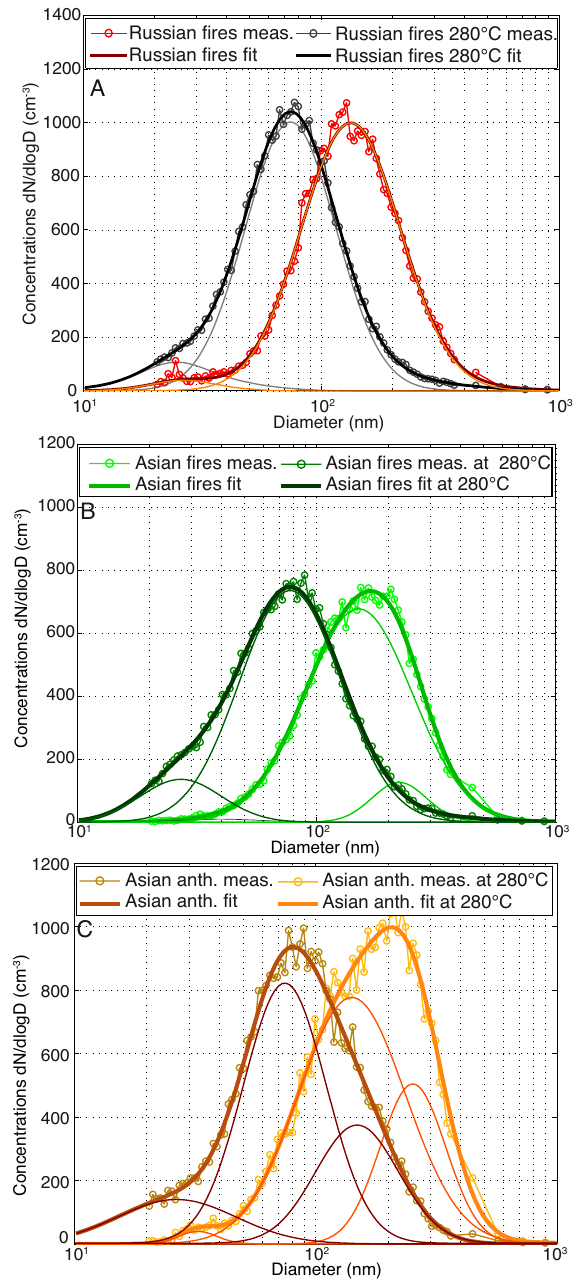
Fig. 12. Ambient and 280 ◦ C aerosol number size distributions for (a) Russian fires air masses and (b) Asian fire and (c) Asian anthro- pogenic air masses.